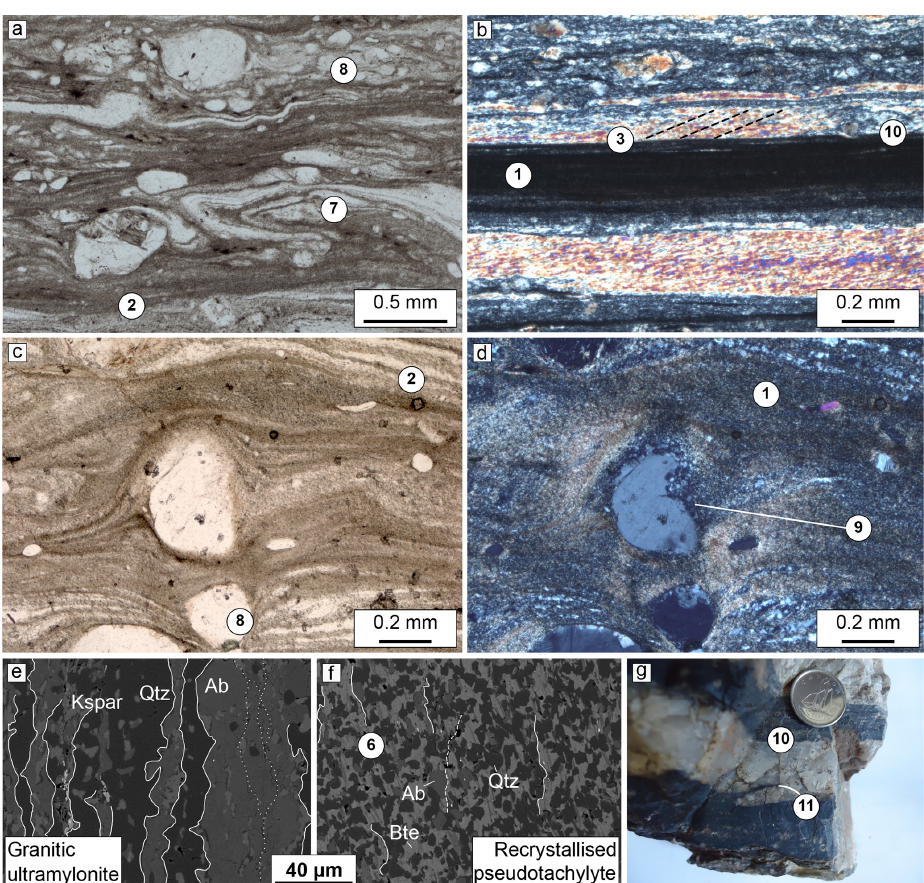
Figure 6. Pseudotachylyte/black ultramylonite microstructures. Numbers in circles highlight microstructural identification criteria listed in the text. (a) Flow folds (2) including eddies around polycrystalline (7) and quartz (8) survivor clasts in a layered biotite-rich/quartz matrix. (b) Isotropic pseudotachylyte (1) sharply cross cuts (10) grain shape preferred orientation in granitic mylonite layer (3). Note the colors are skewed toward brighter interference colors because the section is slightly thicker than 30µm, which emphasises the crystallographic preferred orientation. (c,d) Same field of view; (c) is non-polarised transmitted light and (d) is cross-polarised. Embayed feldspar survivor grain (8) with mantle of feldspar-rich matrix (9) interpreted as partially melted and dragged along flow banding (2; toward the right side away from the grain) forming a tail of quartz-enriched pseudotachylyte within the mixed biotite–quartz matrix (1). (e,f) SEM backscatter images of granitic ultramylonite ( e ; same as Fig. 4f) and black ultramylonite ( f ; same as Fig. 4h) matrices. Interconnected porous horizons (annotated with sparse dashed lines) and phase boundaries extending along multiple grain boundaries (annotated with solid lines; 6). Albite grains are delineated to increase contrast relative to quartz grains. (g) An injection vein is shown in hand